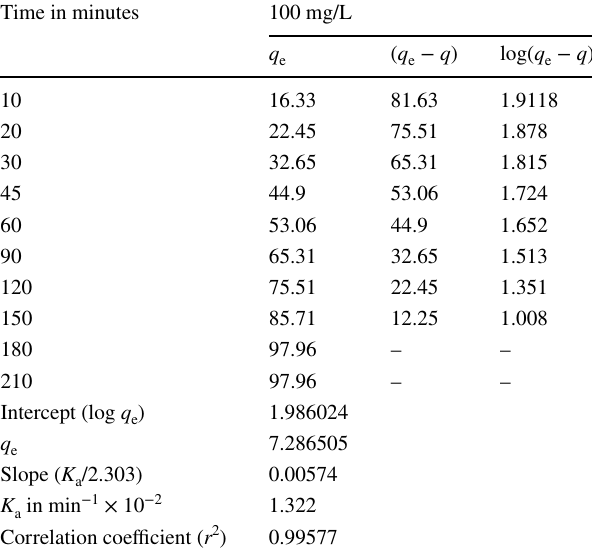
Table 1 Kinetic modelling for adsorption of chromium(VI)